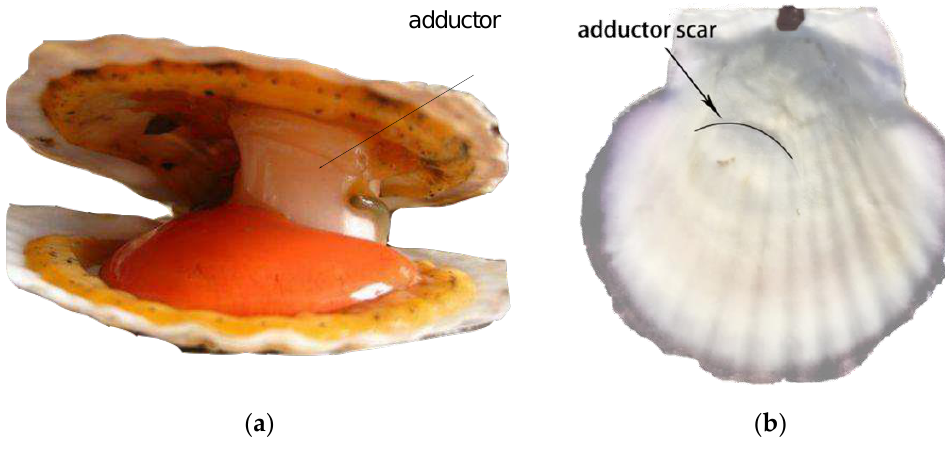
Figure 1. Connection structure between scallop shell and adductor muscle and internal surface structure of shell: ( a ) connection structure, and ( b ) internal surface structure.